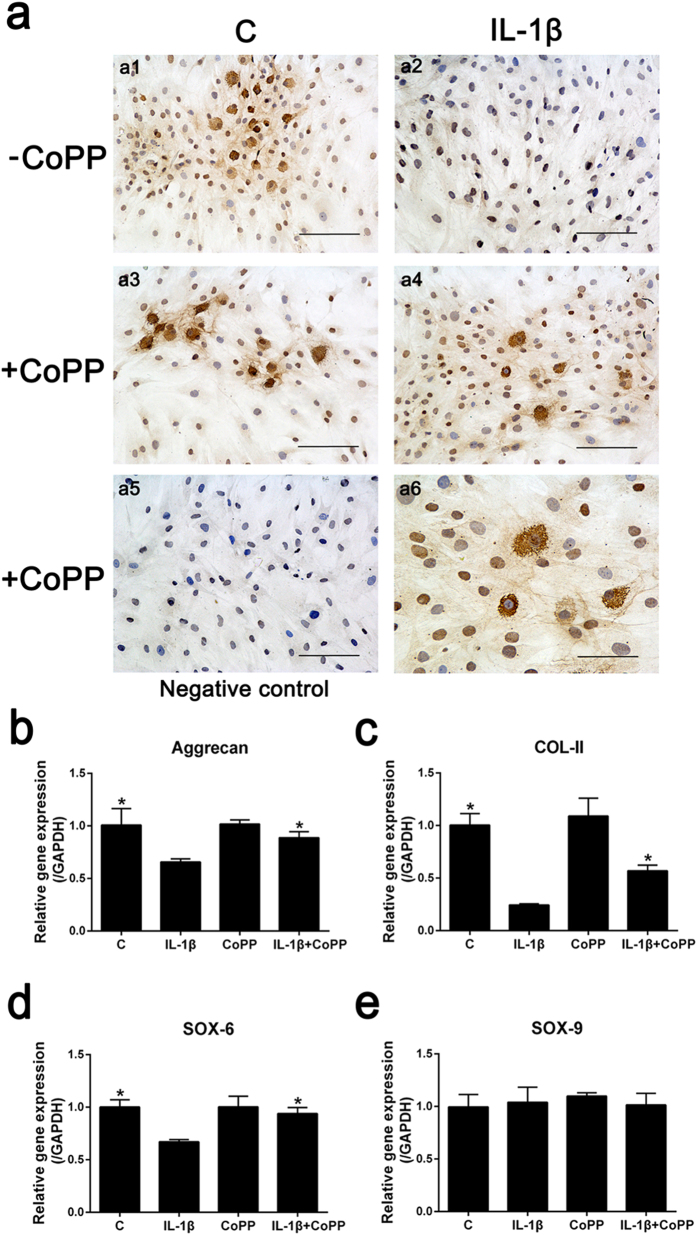
CoPP rescues ECM anabolic gene expression and collagen type II deposition in IL-1β-treated cells (a) Immunocytochemistry assay revealed that IL-1β treatment downregulated the expression of COL-II in human NP cells (a2). Stimulation with the HO-1 inducer CoPP partially abolished the effect of IL-1β and prevented the loss of COL-II deposition induced by IL-1β (a4,a6). Bars = 100 μm (a1–a5) or 50 μm (a6). Real-time PCR showed that IL-1β treatment led to a remarkable downregulation of gene expression of aggrecan (b), COL-II (c) and SOX-6 (d) in human NP cells, and addition of CoPP to the cells treated with IL-1β notably increased the gene expression of aggrecan, COL-II and SOX-6 although they did not reach basal levels. (e) Treatment with IL-1β did not affect the gene expression of SOX-9 in human NP cells. Values represent the mean and SD. *P < 0.05 with respect to IL-1β.